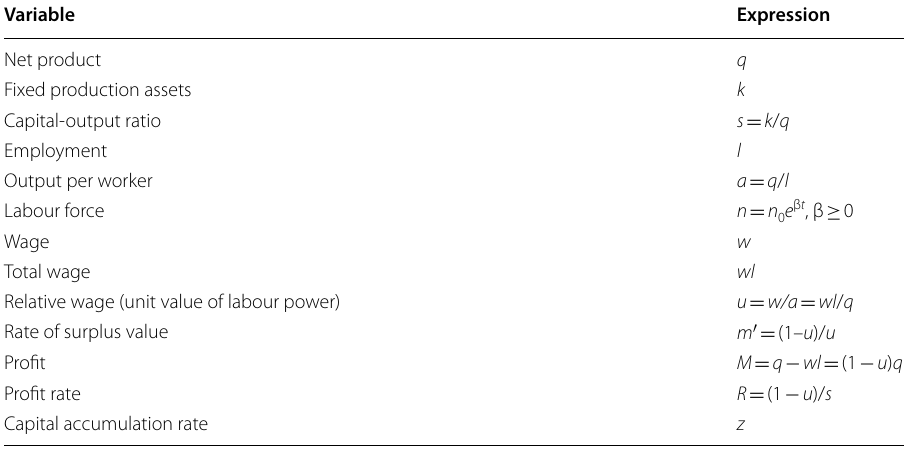
Table 1 Main variables of the models